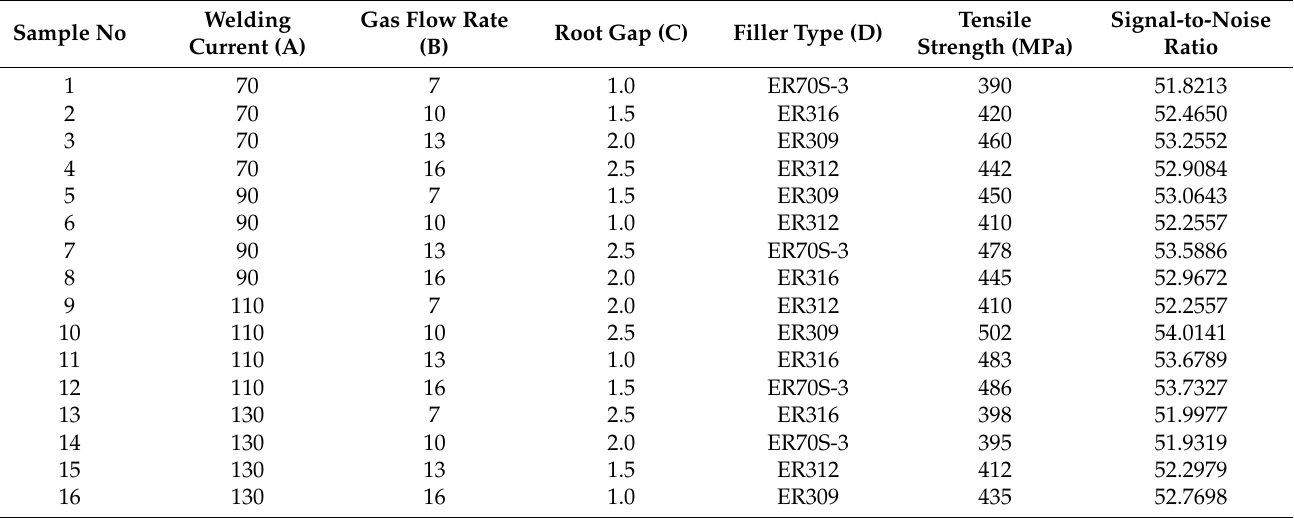
Table 7. Mean tensile strength